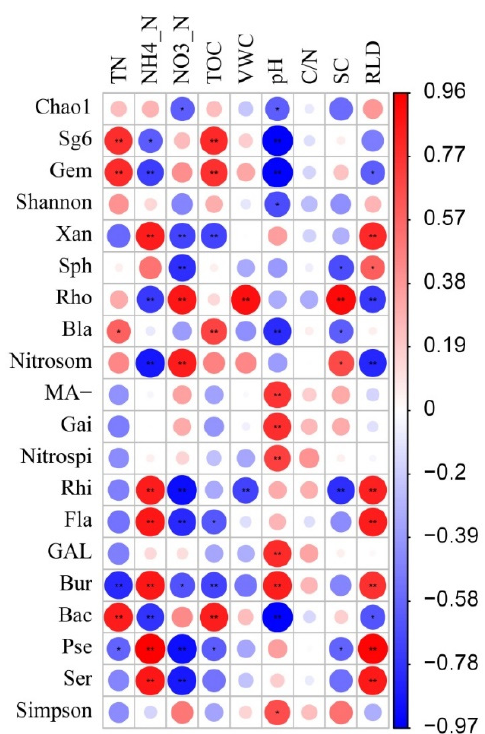
Figure 7. Pearson correlation coefficients between bacterial alpha diversity index, dominant bacte- rial abundance and soil physicochemical property, root length density in plow layer (0–20 cm). GAL : GAL15 , Sg6 : Subgroup_6 , Gem : Gemmatimonadetes , Bla : Blastocatellia , MA- : MB-A2-108 , Aci : Acidimi- crobiia , Sph : Sphingomonadales , Xan : Xanthomonadales , Rho : Rhodospirillales , Rhi : Rhizobiales , Nitrosom : Nitrosomonadales , Fla : Flavobacteriales , Nitrospi : Nitrospirales , Bur : Burkholderiales , Gai : Gaiellales , Bac : Bacillus , Pse : Pseudomonas , Ser : Serratia . Significant differences in relative abundance between dif- ferent treatments are marked with a star: * p < 0.05, ** p < 0.01. The same as below. Redundancy Analysis also showed that there was a significant differentiation of soil bacterial communities under different tillage practices (Figure 8). As can be seen from the figure, the NH 4 -N content, pH and RLD of the ST treatment are higher, and GAL15 , MB- A2-108 , Xanthomonadales , Rhizobiales , Flavobacteriales , Nitrospirales , Burkholderiales , Gaiel- lales , Pseudomonas and Serratia were enriched here. The relative abundance of these bacte- ria was related to higher NH 4 -N content, pH and RLD. However, the RT treatment con- tained higher concentrations of Subgroup_6 , Gemmatimonadetes , Rhodospirillales , Nitro- somonadales and Bacillus and higher contents of TN, TOC and NO 3 -N, and the results more directly reflected the differences of bacterial colonies in different treatments and their cor- relation with soil physical and chemical properties and root length density.